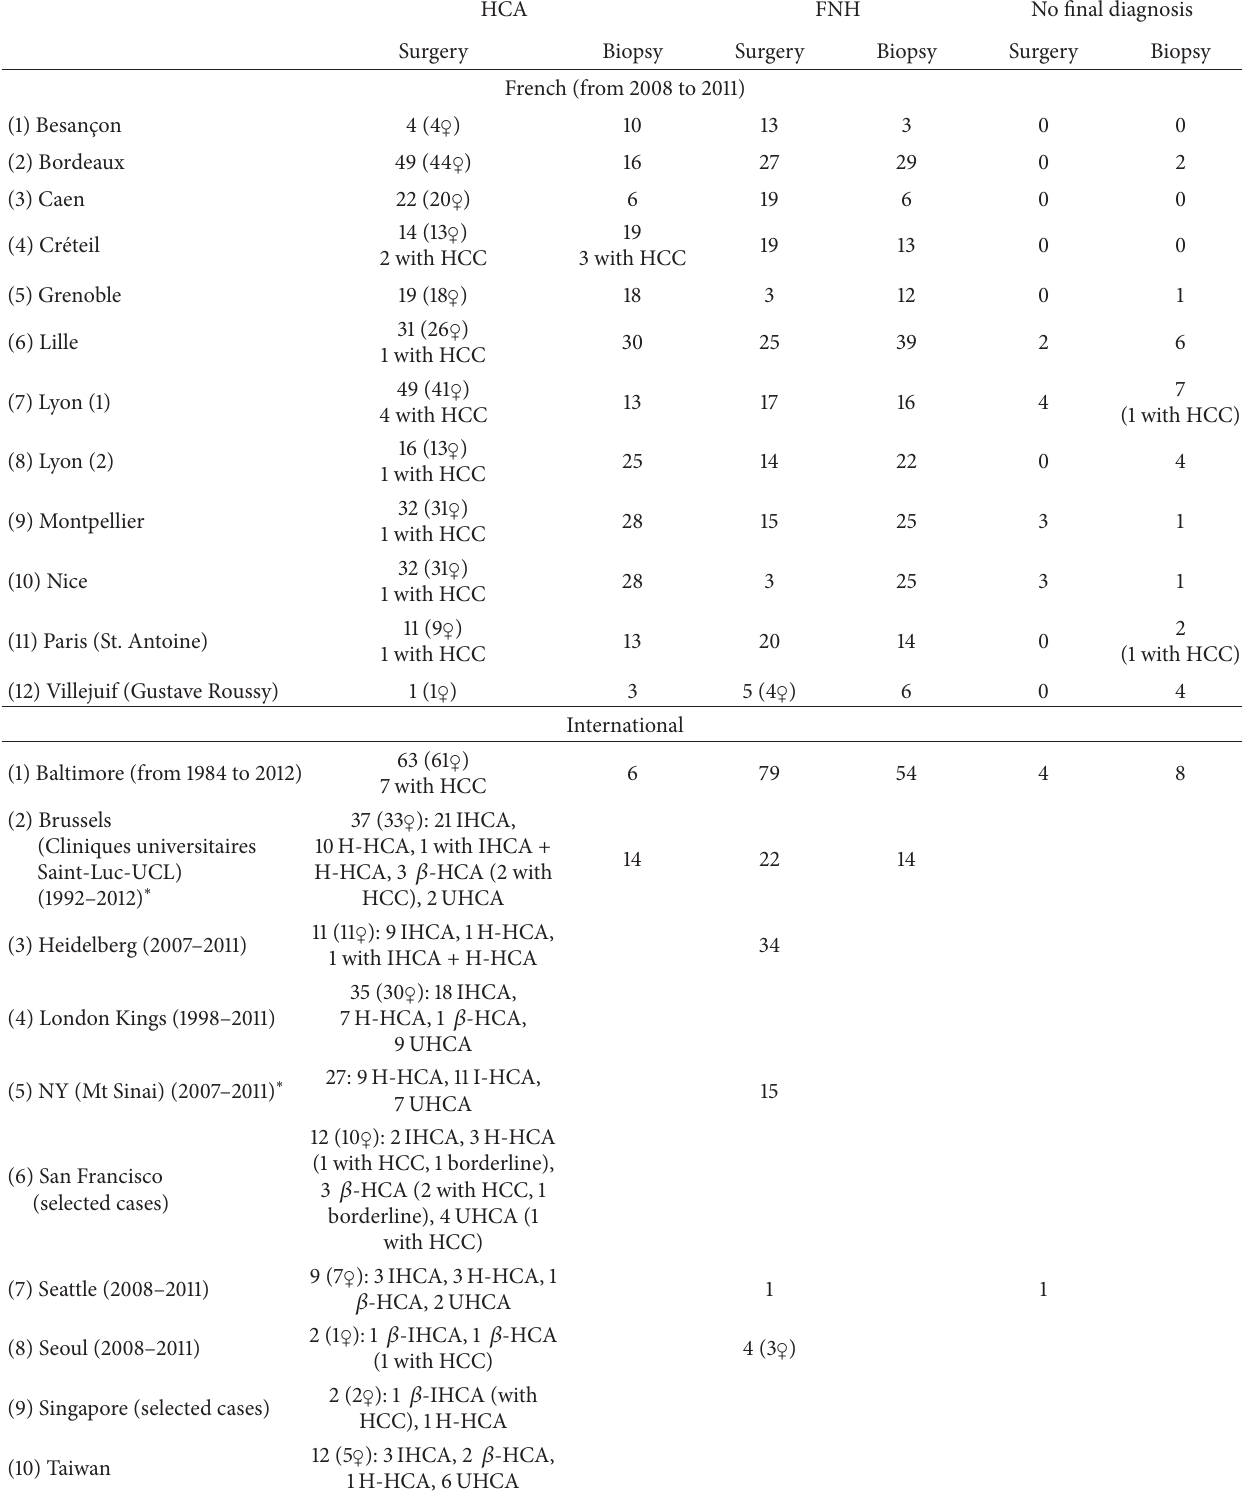
Table 1: Diagnosis of FNH and HCA performed in different academic